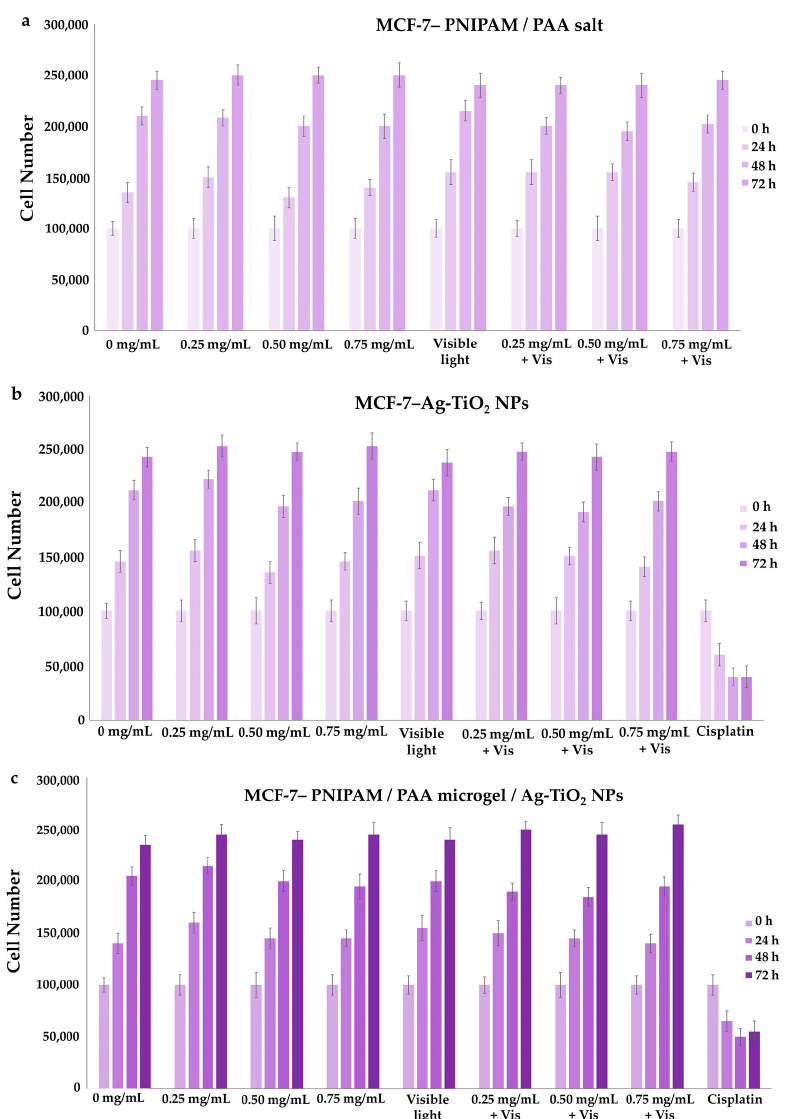
Figure 18. Growth rates of MCF-7 cell line, with the addition of ( a ) PNIPAM/PAA salt, ( b ) Ag-TiO 2 NPs and ( c ) PNIPAM/PAA microgel/Ag-TiO 2 . There was no detectable effect on cell proliferation in the presence of each of the produced materials in increasing concentrations, even after their photoactivation. Samples treated with cis platin were used as positive controls in the experiment. In these series of experiments, p < 0.05 was considered statistically significant.